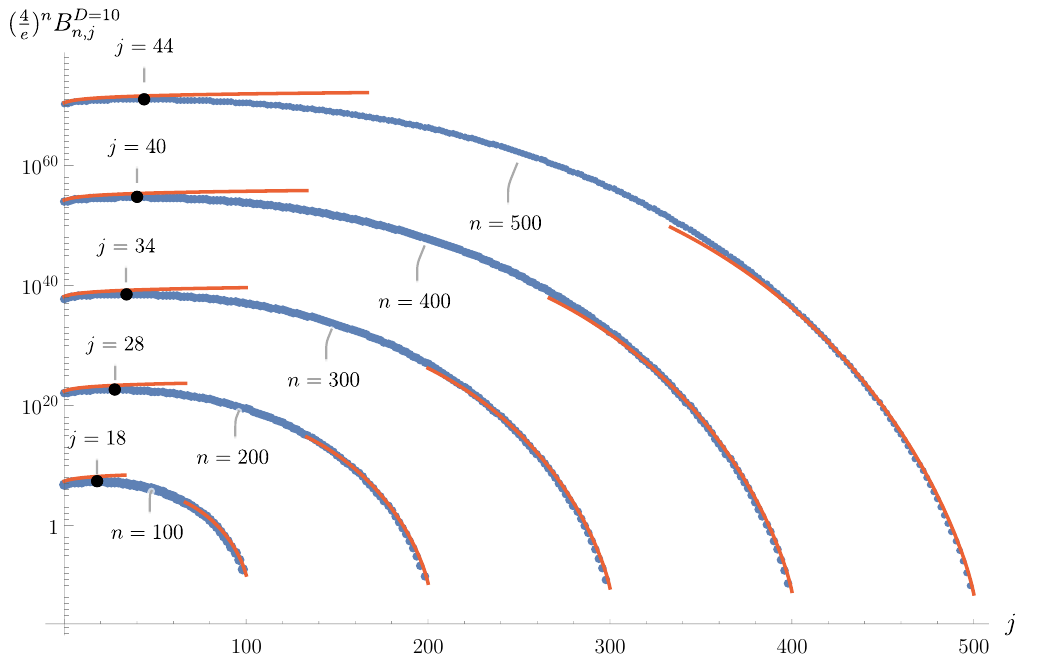
Figure 2 . Coefficients B D =10 for the type I superstring for five different values of n plotted in blue n,j against j on a logarithmic scale. Only coefficients with n + j odd are plotted and they have been rescaled by ( 4 ) n to make the plot more readable. In each case, a peak is reached near j ∼ 2 e indicated with black dots, in qualitative agreement with the asymptotic formula for density of states derived in [12]. The asymptotic formulas that are derived in section 4.3 for small- j and small- ∆ = n − j are both plotted in